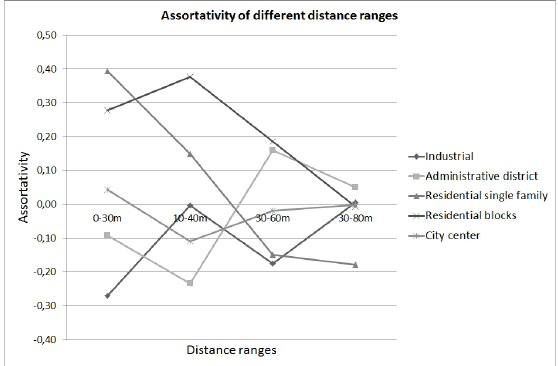
Figure 6: Assortativity of planar graphs for different distance ranges